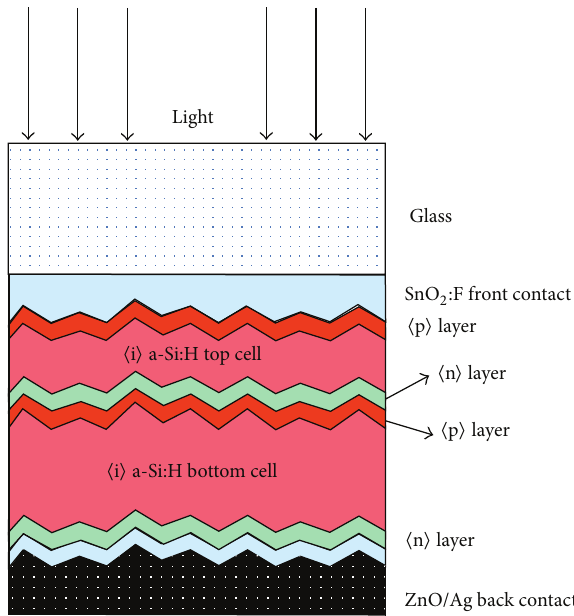
Figure 1: Schematic drawing of the layer stack used for the deposition of a-Si:H/a-Si:H tandem solar cells.